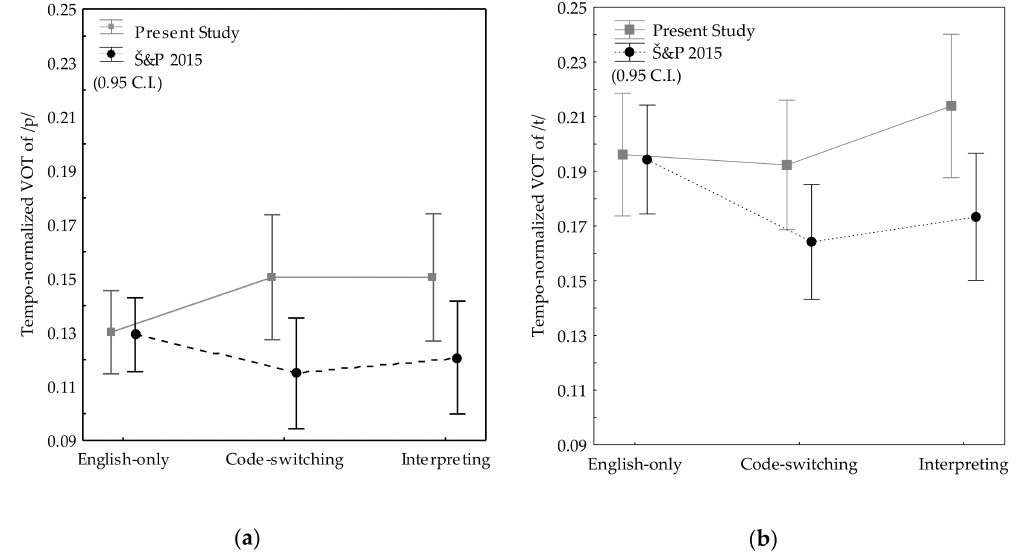
Figure 1. Mean Normalized Voice Onset Time (VOT) values produced by the bilinguals in Šim á ˇckov á and Podlipsk ý (2015) (in the figure, Š&P2015) and the Present Study during the English-only, Code-switching, and Interpreting tasks ( a ) the bilabial voiceless stop; ( b ) the alveolar voiceless